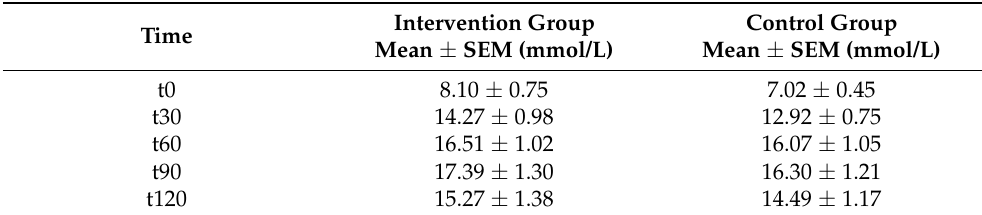
Table 3. Mean blood glucose levels (mmol/L) obtained for control ( n = 18) and intervention group ( n = 18) at different moments: before intervention (t0) and 30 (t30), 60 (t60), 90 (t90) and 120 (t120) minutes after intervention.